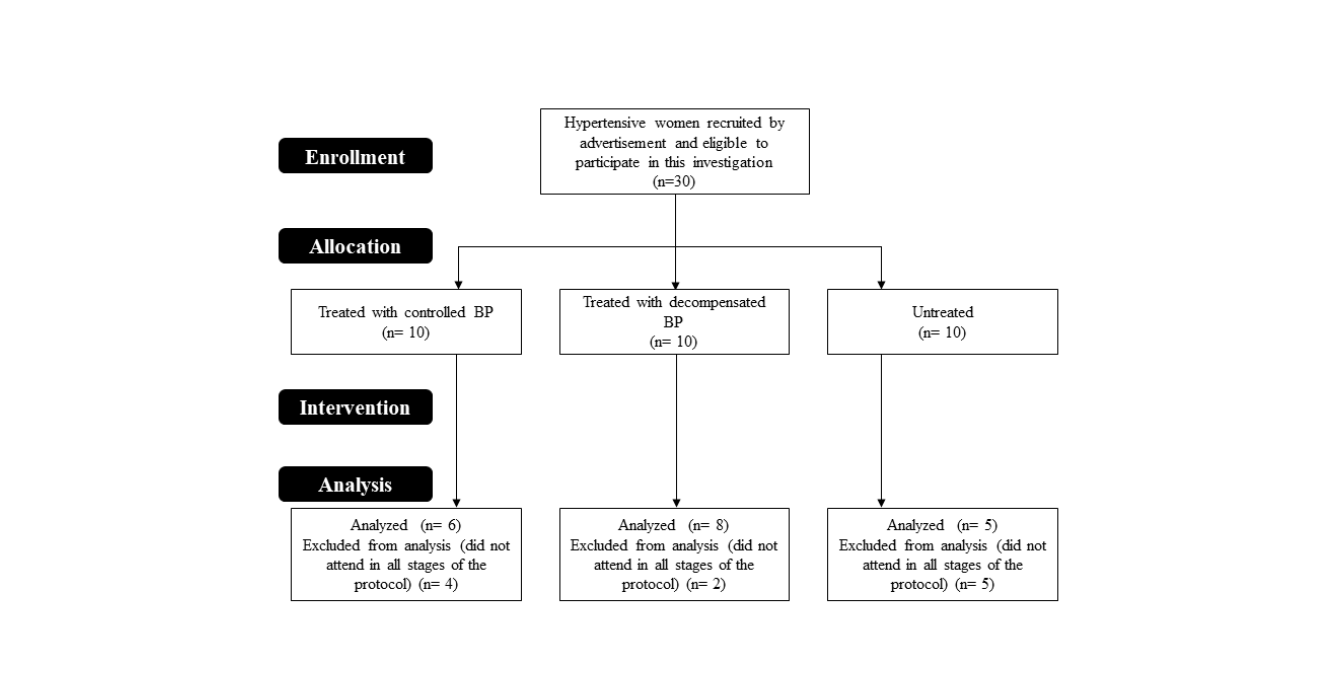
Figure 1 - Flowchart summarizing the enrollment and classification of subjects for this study. BP: blood